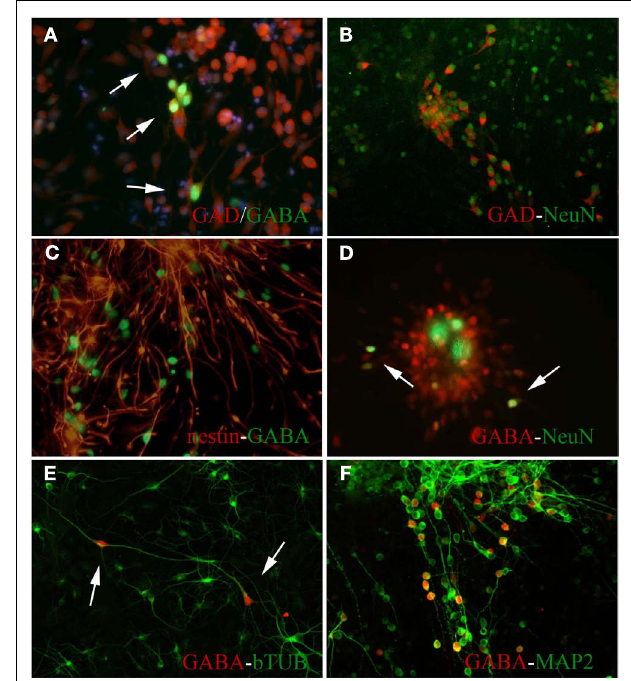
FIGURE 3 | Briefexposure to varying concentrations of FGF-2 induces differentiation of embryonic cortical progenitor cells into GABAergic phenotype in cultured neurospheres. Progenitor cells exposed to low concentration of FGF-2 expressed the largest number of GABA-IR cell (A,B) . Majority of these cells were found in or adjacent to the neurospheres and did not show migratory pattern. Progenitor cells exposed to 1 or 10ng/ml FGF-2 did not display as many GABA-IR cells as those exposed to 0.1ng/ml.These GABA-IR cells were found predominantly outside the neurospheres radiating outwardly in a migratory pattern (C,D) . Large proportion of NPCs can be labeled with BrdU, however, the GABA-IR cells did not co-label with BrdU (E) . A high magnification light microscopy image of GABA-IR cells inside a neurosphere labeled with DAB peroxidase reaction (F) . Scale bars = 20 μ m (A) ; 50 μ m (B–E) .